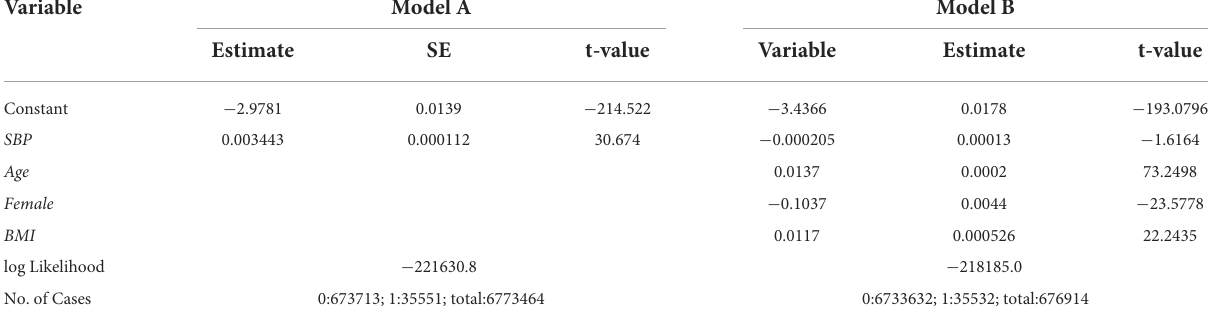
TABLE 1 Results of estimation: models A and